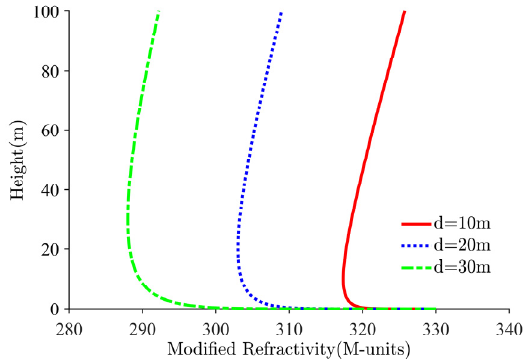
Figure 2. Modified refractivity profiles for different EDHs.